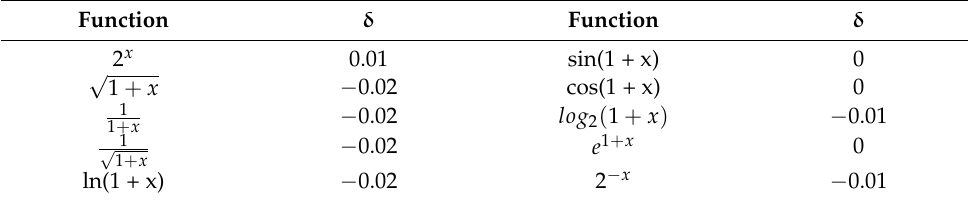
Table 1. The δ for common